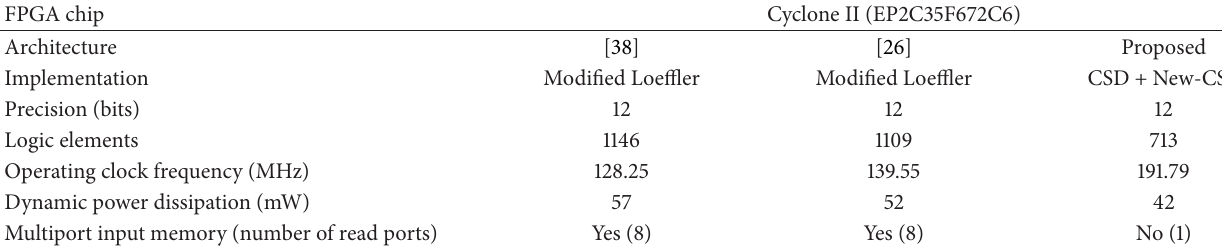
Table 9: Performance analysis of different 1D-DCT architectures on Altera FPGA.